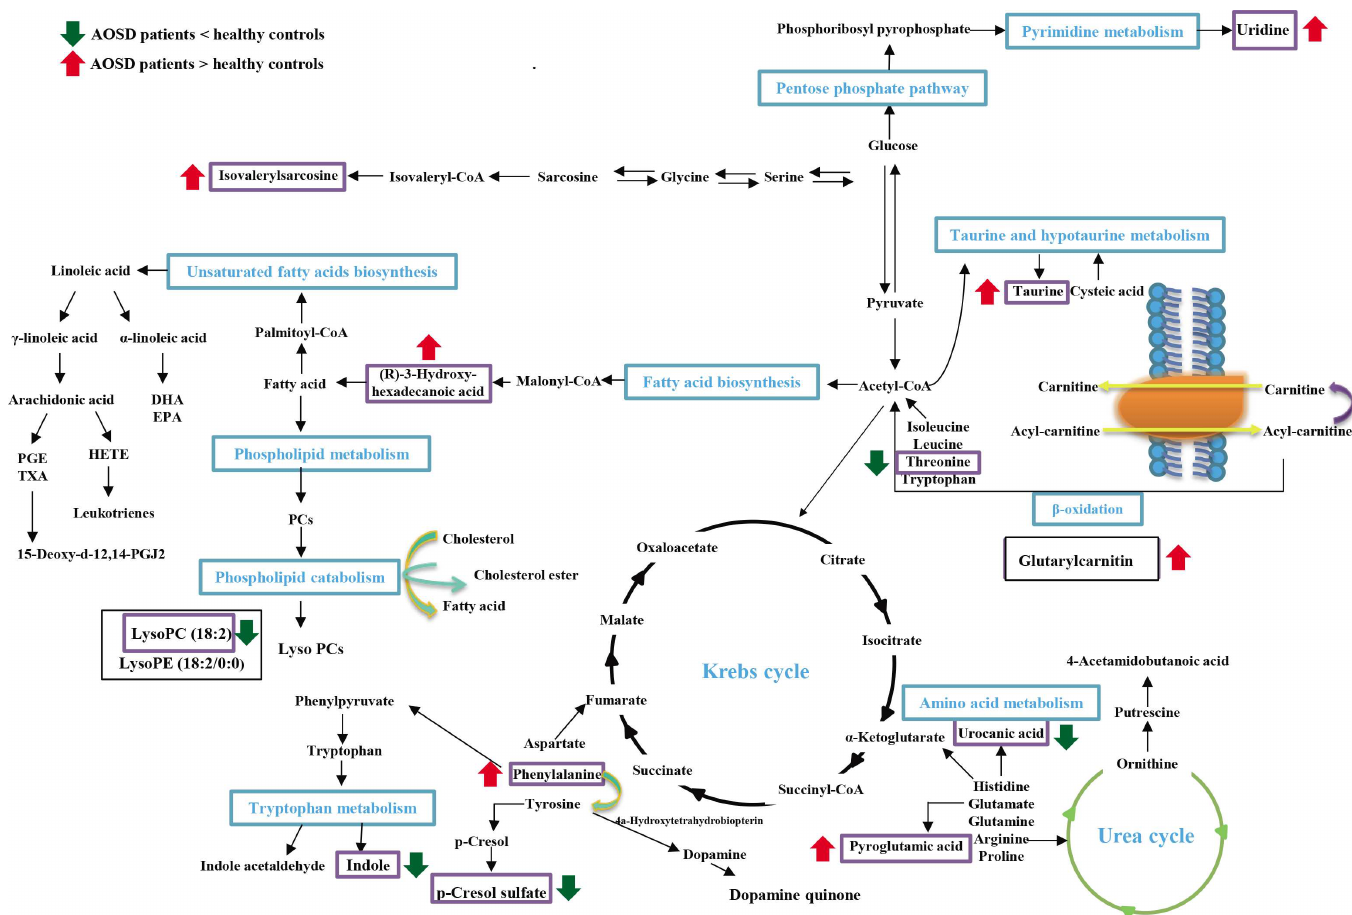
Fig 4. Schematic representation depicts the metabolic imbalance in patients with adult-onset Still’s disease (AOSD). ( " ) represents up-regulated changesobservedin AOSD; ( # ) represents down-regulated changesobserved in AOSD.